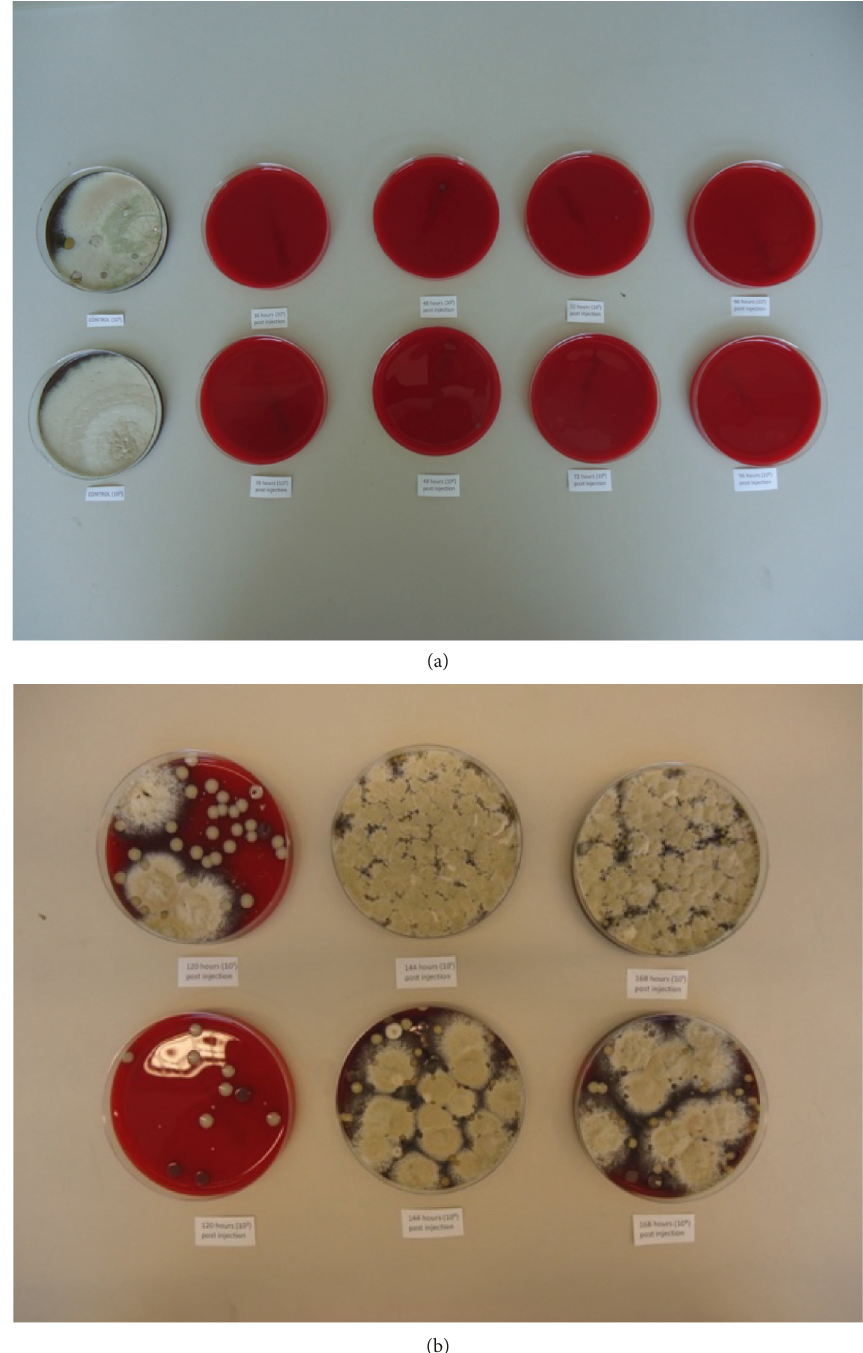
Figure 3: Agar plates of bed bug gut cultures from Test 2 (a) nymphs and (b) adults > 64 days after feeding on the rabbit observed at 72